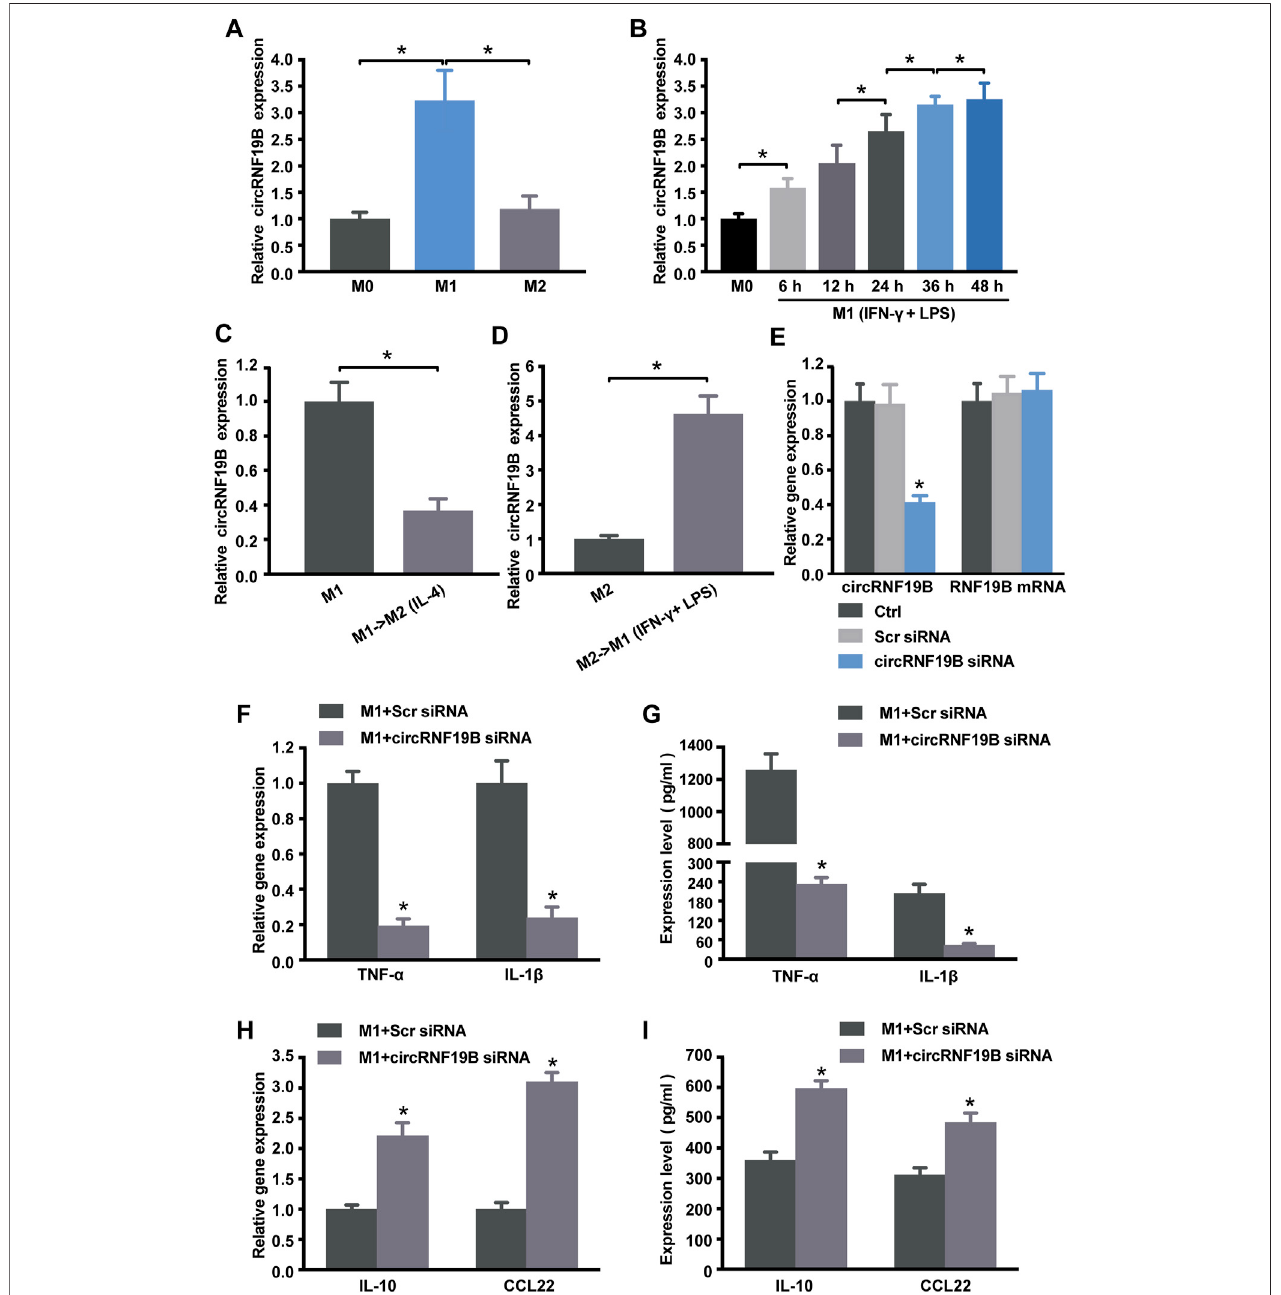
FIGURE 7 | Regulation of circRNA-RNF19B in macrophage polarization. (A) THP-1 macrophages were treated with IFN- γ and LPS for M1 polarization or IL-4 for M2 polarization for 18 h or left untreated (M0). The expression of circRNF19B in each group was detected by qRT-PCR ( n = 4). (B) THP-1 macrophages (M0) were treated with IFN- γ and LPS for M1 polarization for the indicated time points. qRT-PCRs were conducted to detect circRNF19B expression ( n = 5). (C) qRT-PCRs were conducted to detect circRNF19B expression levels in macrophages following M1-to-M2 re-polarization by IL-4 for 18 h ( n = 4). (D) qRT-PCRs were conducted to detect circRNF19B expression levels in macrophages following M2-to-M1 re-polarization by IFN- γ plus LPS treatment for 18 h ( n = 4). (E) THP-1 macrophages were transfectedwithscrambled (Scr)siRNA, siRNAtargetingthesequenceofcircRNF19B,orleftuntreated (Ctrl) for36 hqRT-PCRswereconductedtodetectcircRNF19B and RNF19B mRNA expression ( n = 4, p < 0.05 versus Scr siRNA). THP-1 macrophages were transfected with circRNF19B siRNA or Scr siRNA and then stimulated withLPS and IFN- γ for M1 polarization. M1 markers TNF- α and IL-1 β (F) and M2 markers IL-10 and CCL22 (H) in each group were detected byqRT-PCR at 18 h post- treatment.M1markersTNF- α andIL-1 β (G) andM2markersIL-10andCCL22 (I) inthesupernatantofeachgroupweredetectedbyELISAat48 hpost-treatment( n =5, p < 0.05versusthecorrespondingScrsiRNA).Dataareexpressedasthemeans±SDofatleastthreeindependentexperiments. p < 0.05,signi fi cantdifferencebetween the two groups